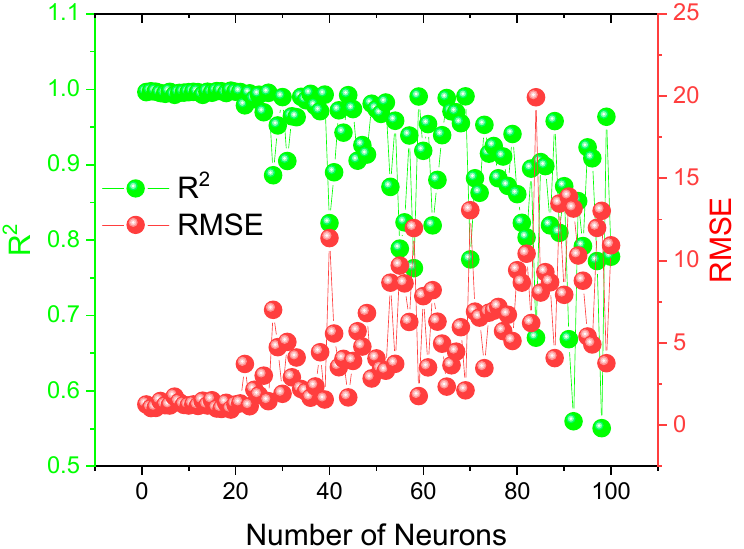
Figure 13. Impact of neuron convergence in the hidden layer.